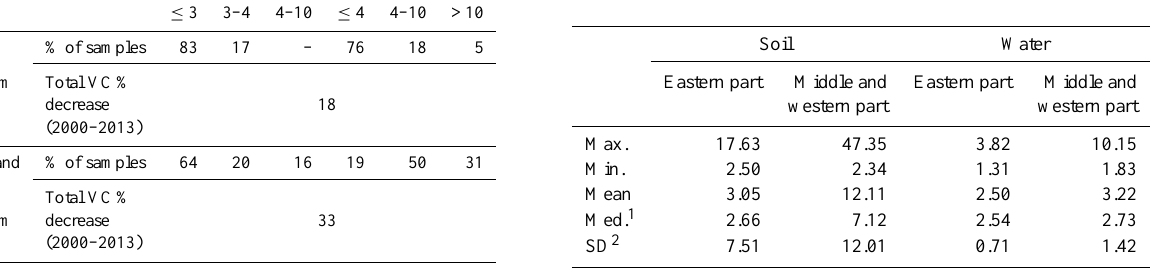
Table 3. Descriptive statistics of EC (dSm − 1 ) of soil ( n = 50) and water samples ( n = 180) in ecosystem areas subjected to sand dune encroachment (eastern part) or salinization (middle and western